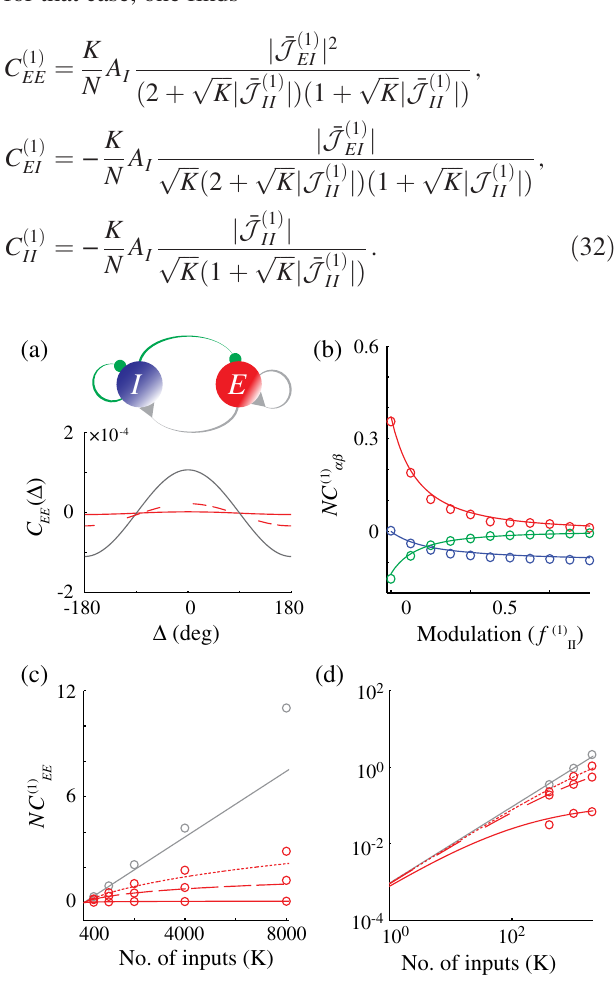
FIG. 4. Spatial modulation in the II interactions suppresses the correlations in the E populations. Same network as in Fig. 3 but 1 Þ f ð ¼ 0 . 25 . N ¼ 40 000 . (a) Top panel: The network architec- II ture. Interactions plotted in green are spatially modulated. Bottom Δ Þ . N ¼ 40 000 , K ¼ 2000 . panel: Simulation results for C EE ð 1 Þ 1 Þ Gray line, f ð ¼ 0 ; dashed red, f ð ¼ 0 . 05 ; solid red, II II 1 Þ 1 Þ ð 1 Þ f ð . Circles: Simulations. Solid lines: ¼ 0 . 25 . (b) NC ð αβ vs f II II Solution of Eq. (32). N ¼ 40 000 , K ¼ 400 . Colors are as in 1 Þ vs K . Solid lines: Eq. (32). Circles: Fig. 3. (c) Left panel: NC ð EE 1 Þ 1 Þ Simulations. Gray line, f ð ¼ 0 ; dotted red, f ð ¼ 0 . 025 ; II II 1 Þ 1 Þ dashed red, f ð ¼ 0 . 05 ; solid red, f ð ¼ 0 . 25 . Right panel: II II Same as left panel but in a log-log